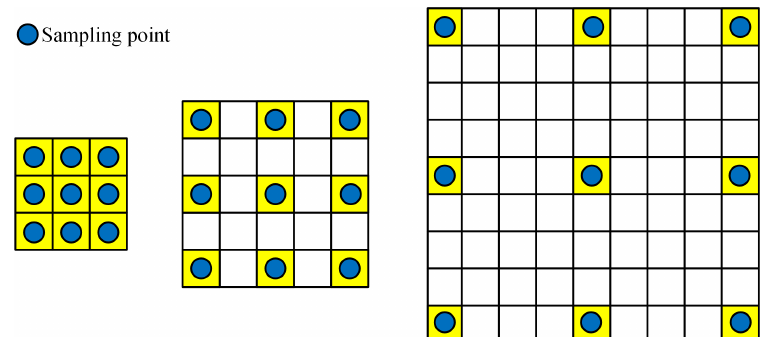
Figure 8. Schematic diagram of dilated convolution expansion.